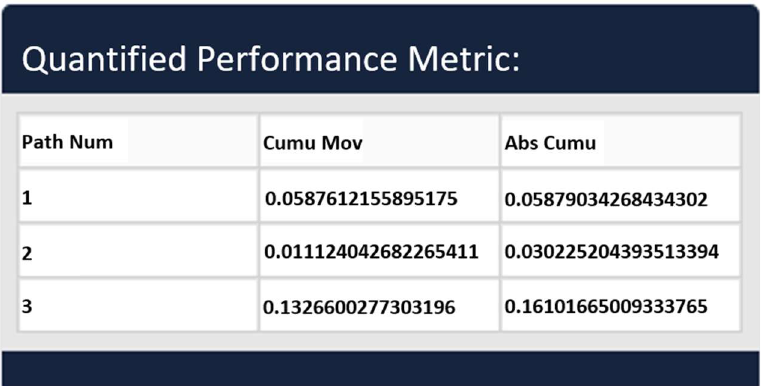
Figure 14. The user interface used to drive operational consequence decision support tool: cumulative movement for each of the proposed operational trajectories.